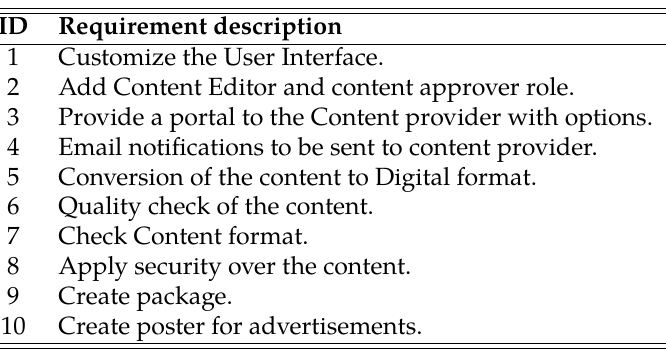
Table 1: Requirement set used in the proof of concept.